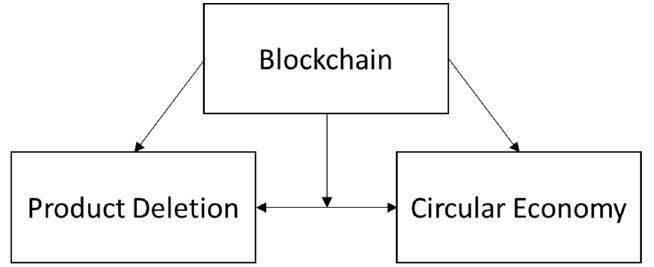
Figure 1. A Conceptual Framework of Product deletion, Circular Economy and Blockchain Relationships.